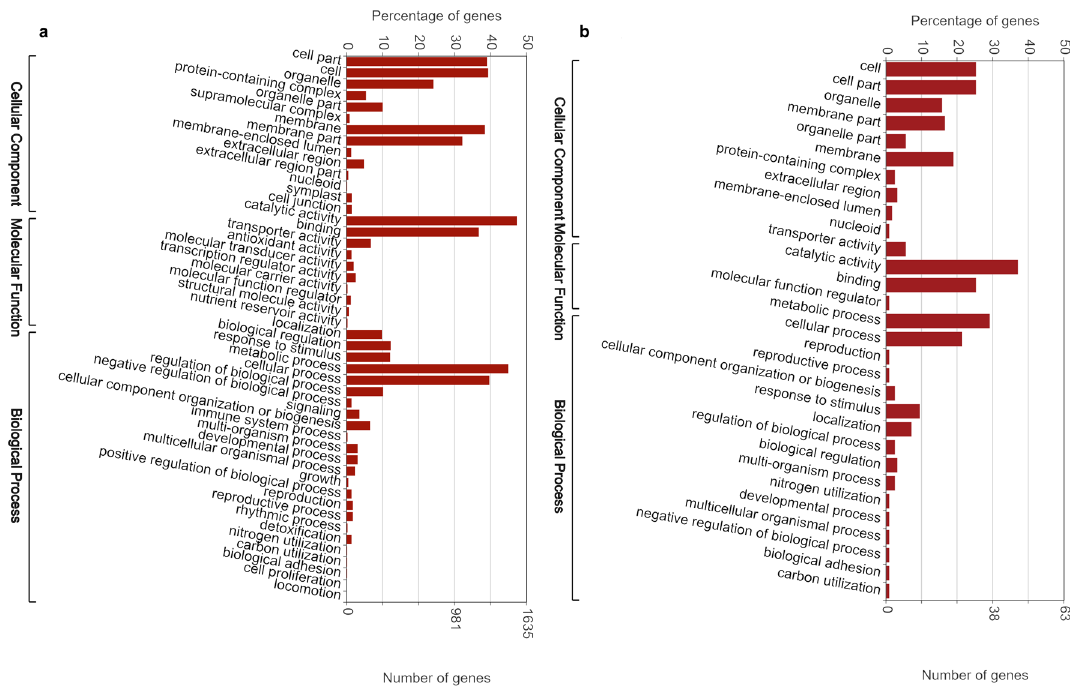
Figure 4. Gene ontology distribution of DEGs: ( a ) SosatC88_MeJA-treated vs non-treated; ( b ) Souna3_MeJA- treated vs